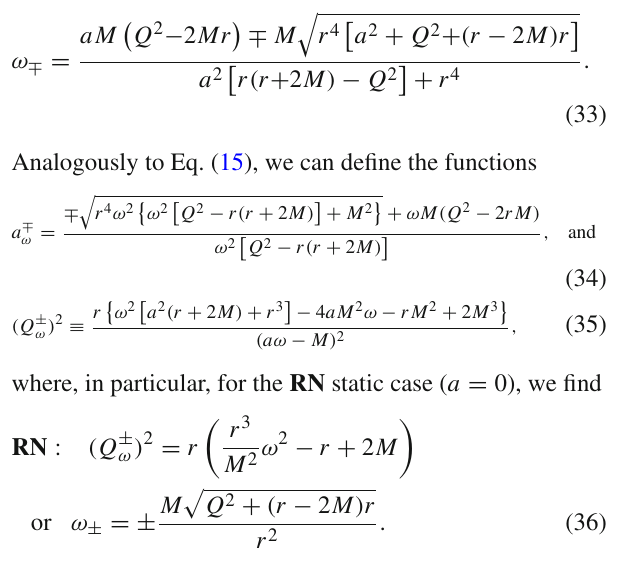
Fig. 20 Equatorial plane of the Kerr–Newman spacetimes: the sur- faces ω ± = constant as functions of the radius r / M and the electrical charge Q / M – Eq. (34), for different spins. This is a generalization of